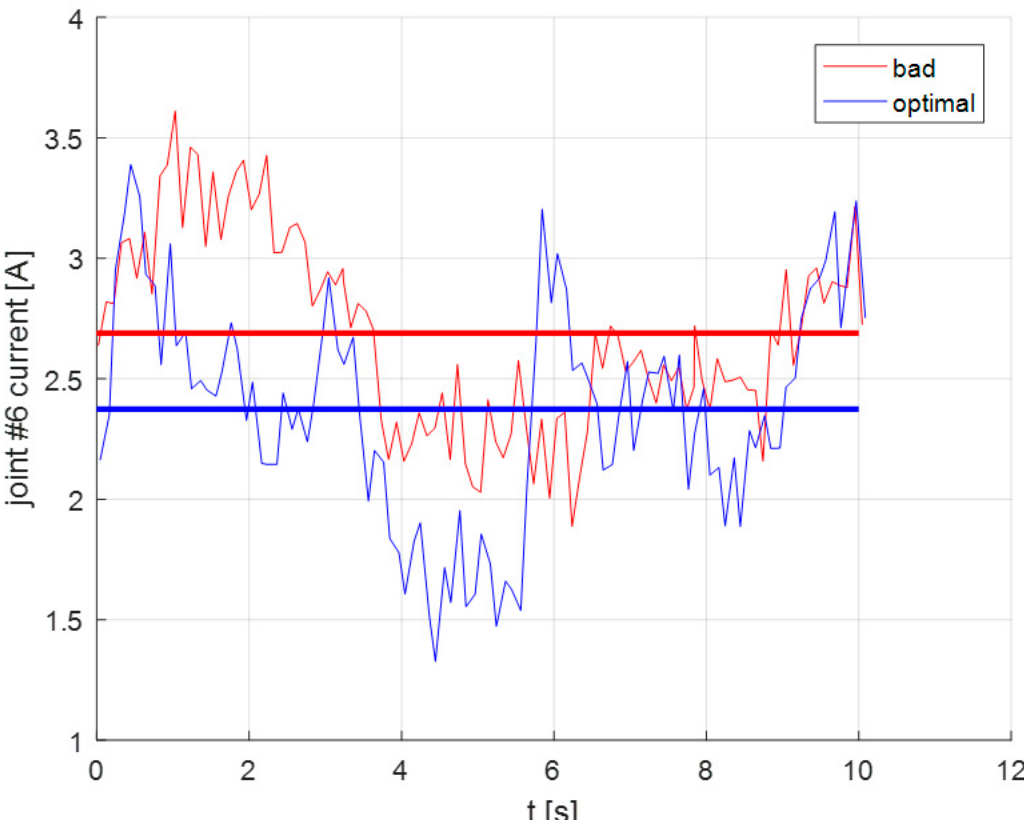
Figure 13. Total current utilization and total mean during task execution in both